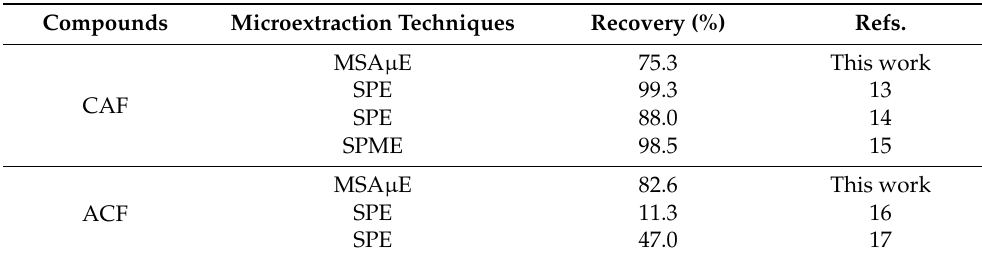
Table 1. Comparison of average recovery yields of both tracers achieved by the current method and other microextraction